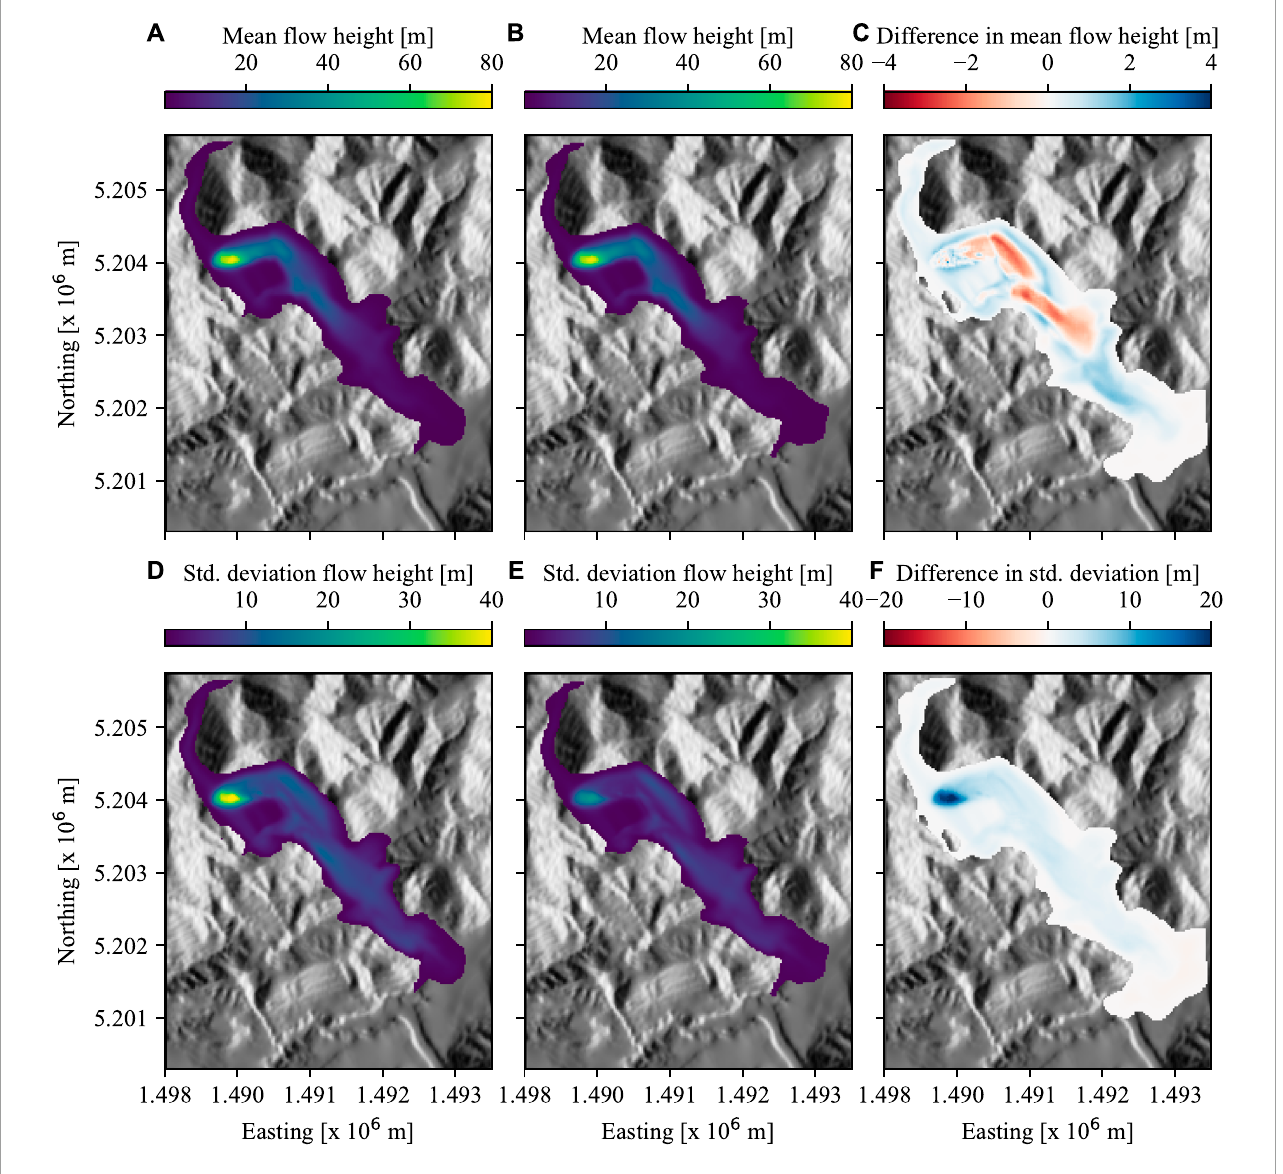
FIGURE 8 Spatial distribution of mean and standard deviations of maximum flow height ( h max ) from Acheron rock avalanche obtained with (A, D) Point Estimate Method (PEM) and (B, E) Monte Carlo Simulations (MCS) at 50% coefficient of variation. Differences of (C) mean value and (F) standard deviation are plotted by subtracting MCS results from PEM